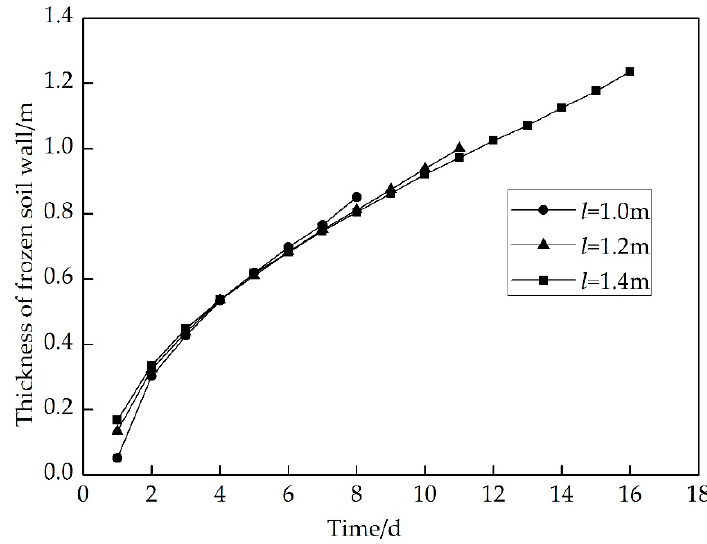
Figure 12. The thickness evolution of frozen soil wall.